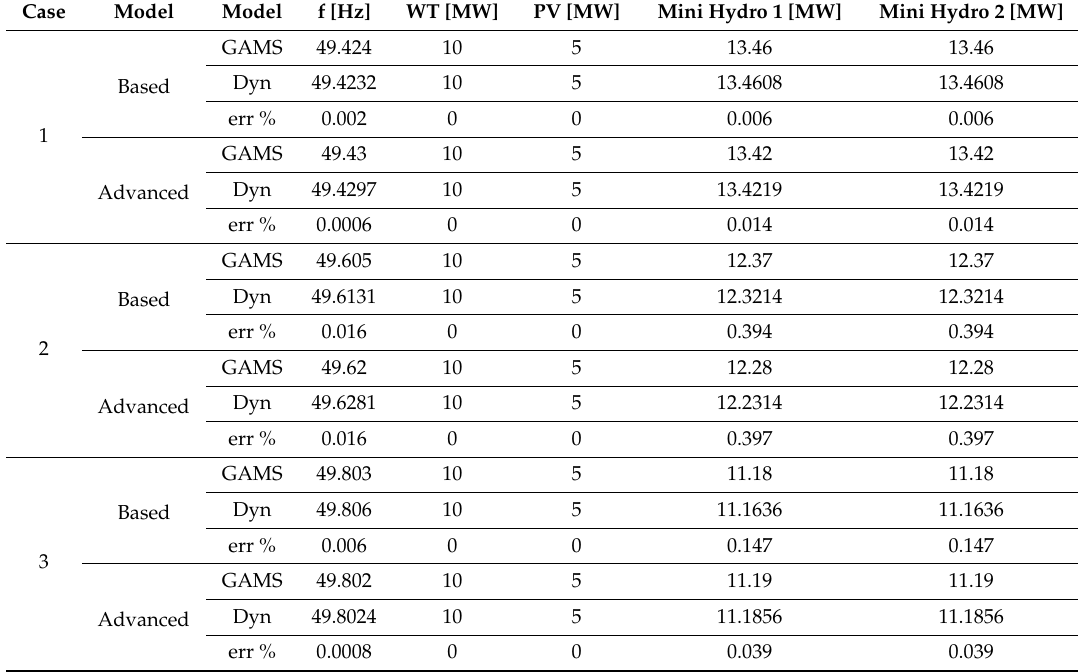
Table 5. Optimization against dynamic simulations comparison: the base